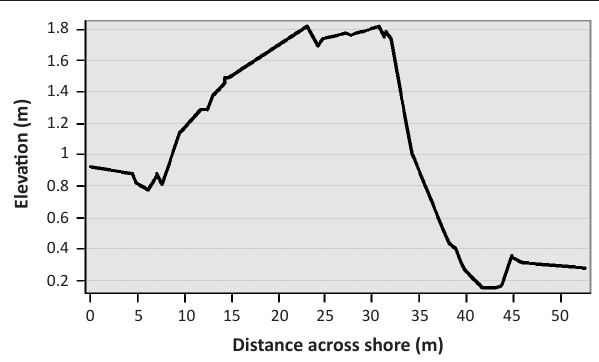
FIGURE 9: Cross-shore profile on part of the central beach.